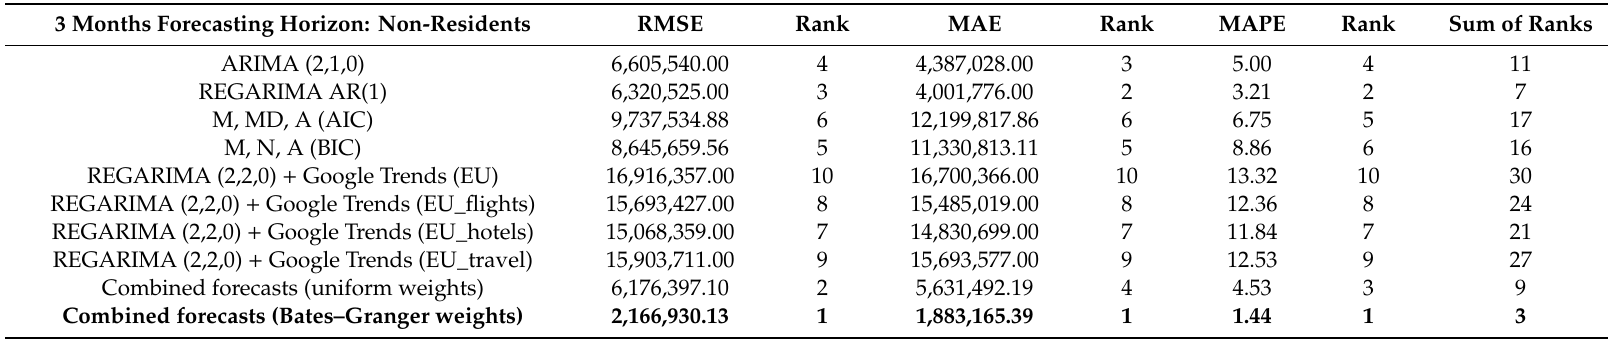
Table A5. Forecasting accuracy (December 2017): overnights, non-residents, three months ahead. Source: European Commission (2017) and own calculations. Boldface indicates the single forecasting model(s) / forecast combination technique(s) characterized by the lowest sum of ranks. 3 Months Forecasting Horizon: Non-Residents